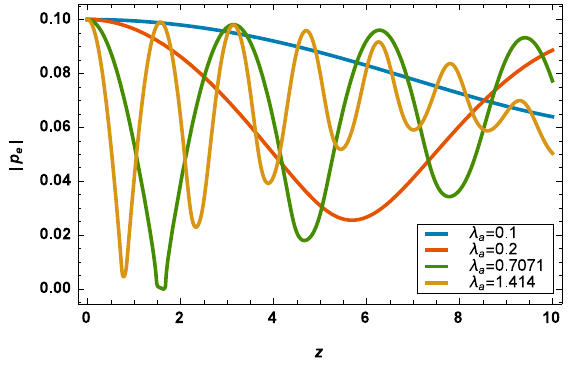
Fig. 1 Pressure along Straight Tube for Different Values of λ a with α = 20 , β = 0 .